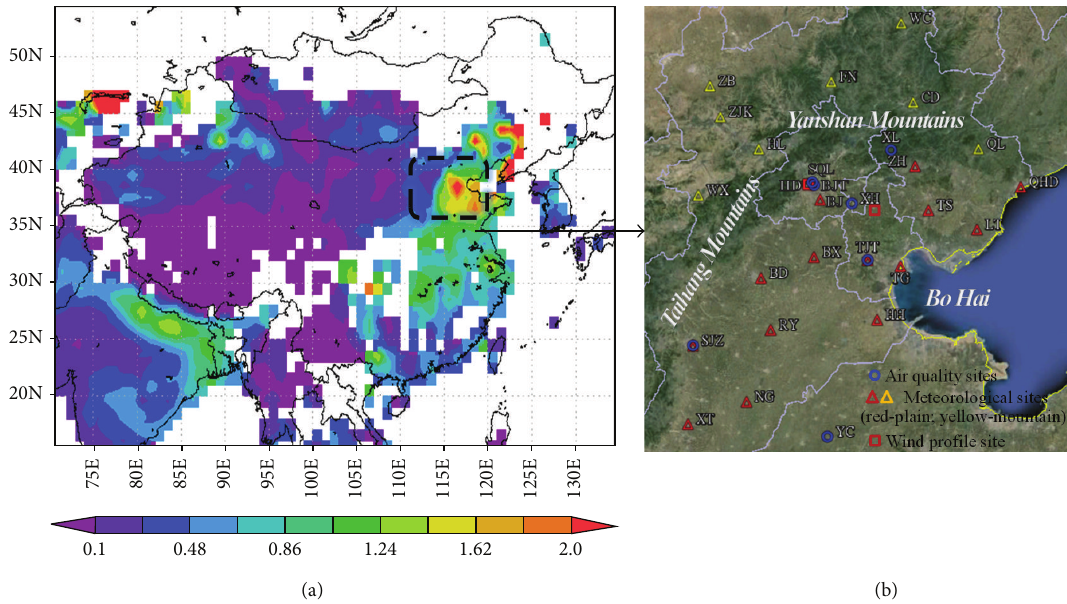
Figure 1: (a) Monthly mean deep-blue AOD at 550 nm wavelength in January 2013 over China derived from Aqua MODIS 1 ∘ × 1 ∘ level-3 daily products. (b) Topographic map and the locations of meteorological and air quality measurement sites over the BTH